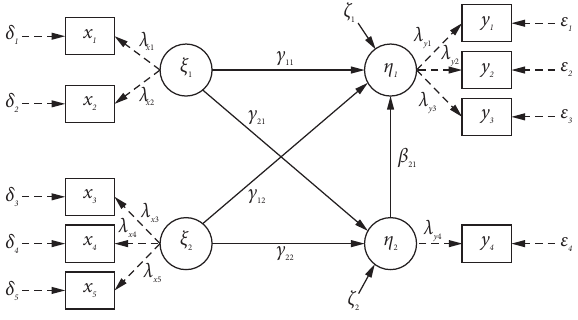
Figure 1: Structural and measurement model of